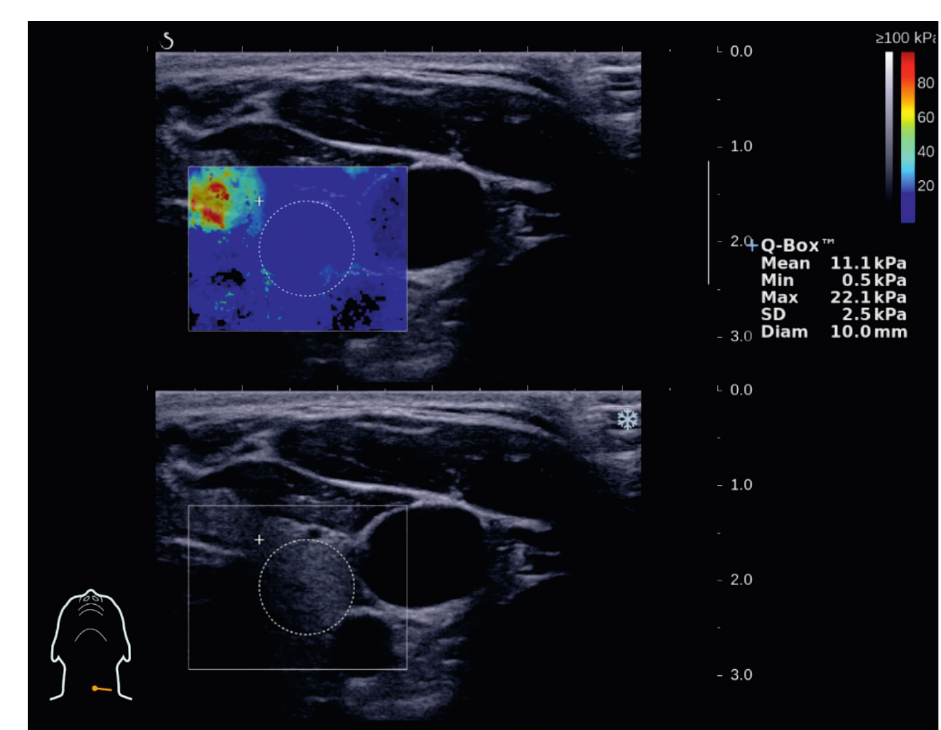
Fig. 1. Thyroid gland with the ROI (region of interest) placed in the left lobe; patient with Hashimoto’s thyroiditis.